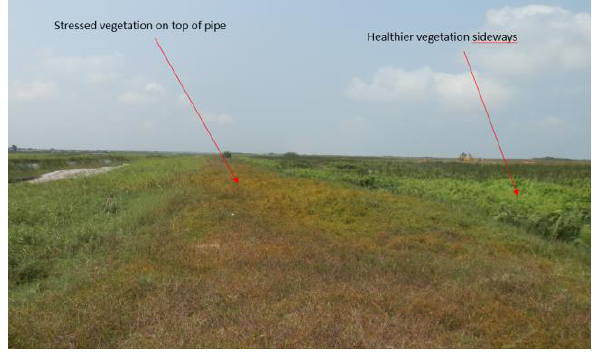
Figure 5: South-East ward looking view showing sparse drier vegetation on top of pipe compared to the vegetation on the sides. Humidity on top on pipe is less than 1%.